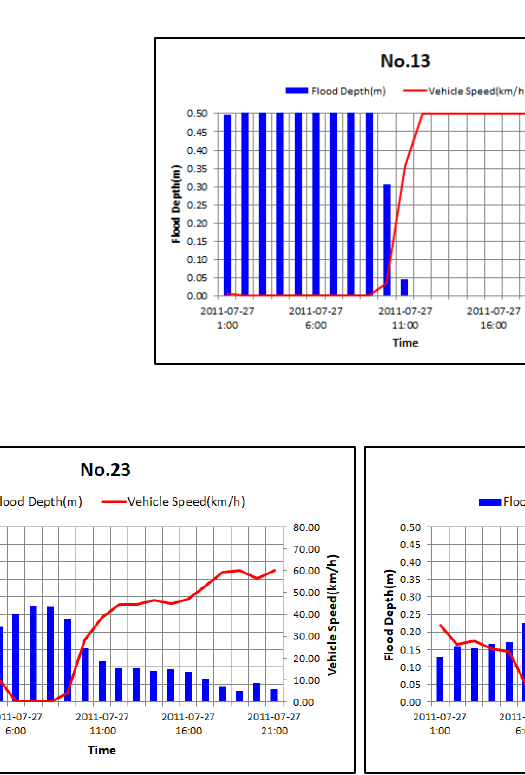
Figure 17. Result of rainfall – depth – vehicle speed relationship.